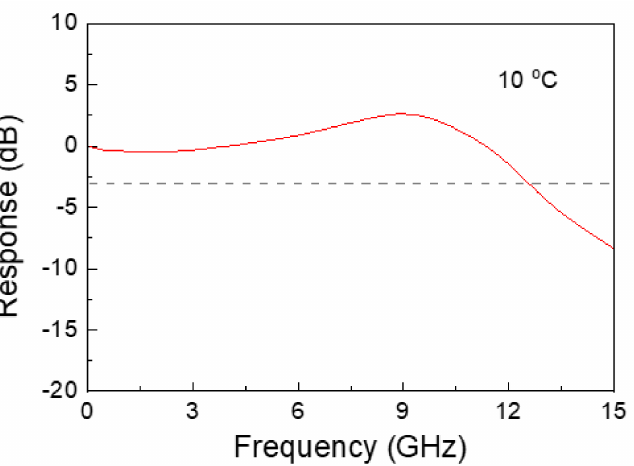
Figure 4. Small-signal modulation response at 10 ◦ C when the gain section and DBR section were biased at 80 and 0